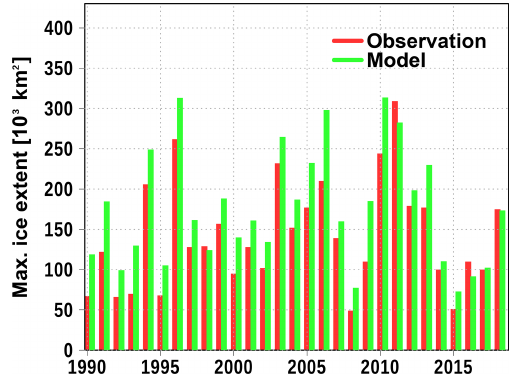
Figure A1. Simulated (green) and observed (red) maximum sea ice extent. Observations are obtained freely from https: //en.ilmatieteenlaitos.fi/ice-winter-in-the-baltic-sea (last access: